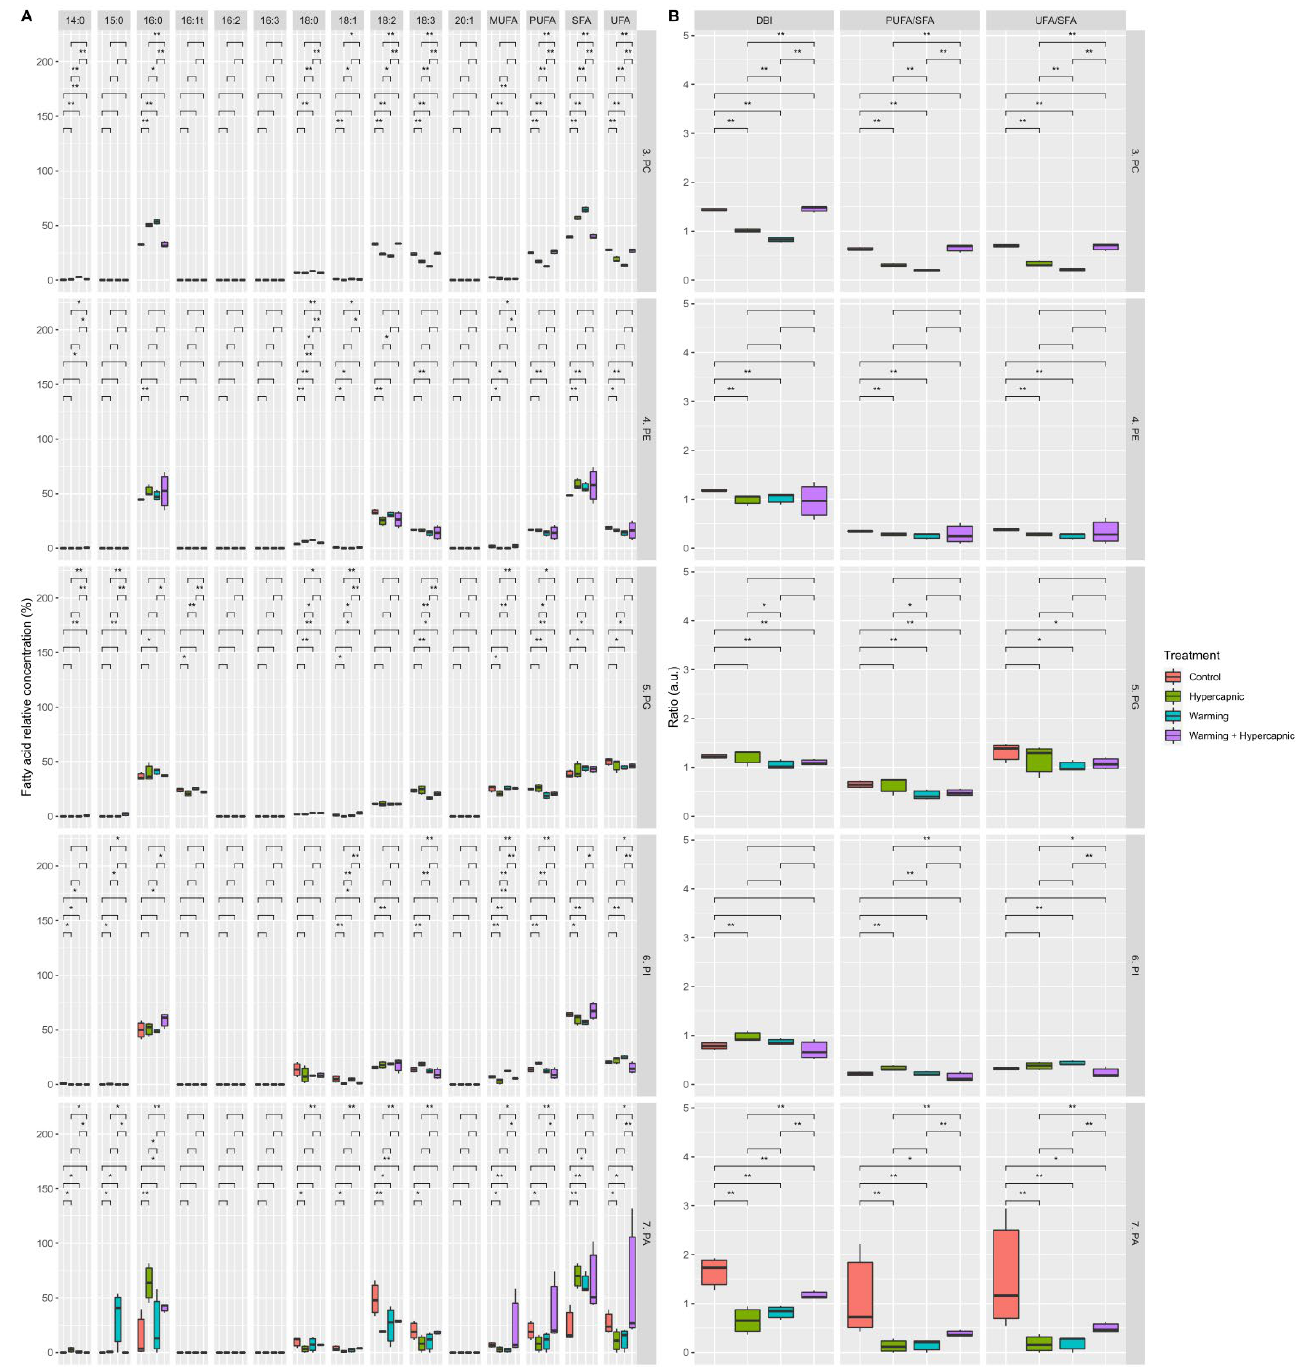
Figure 7. Zostera noltii phospholipid (phosphatidylcholine (PC), phosphatidylethanolamine (PE), phosphatidylglycerol (PG), phosphatidylinositol (PI), and phosphatidic acid (PA); numbers indicate the order of appearance of the lipid fractions in the TLC plate) fatty acid composition, saturation, and classes (monounsaturated fatty acids (MUFAs), polyunsaturated fatty acids (PUFAs), saturated fatty acids (SFAs), and unsaturated fatty acids (UFAs)) ( A ) and fatty acid indexes and ratios (double-bond index (DBI), polyunsaturated to saturated fatty acid ratio (PUFA/SFA), and unsaturated to saturated fatty acid ratio (UFA/SFA)) ( B ) under exposure to control, hypercapnic, warming and combined stress conditions ( n = 3 per treatment; asterisks denote statistical differences among treatments at p < 0.05 (*) and p < 0.01 (**)).